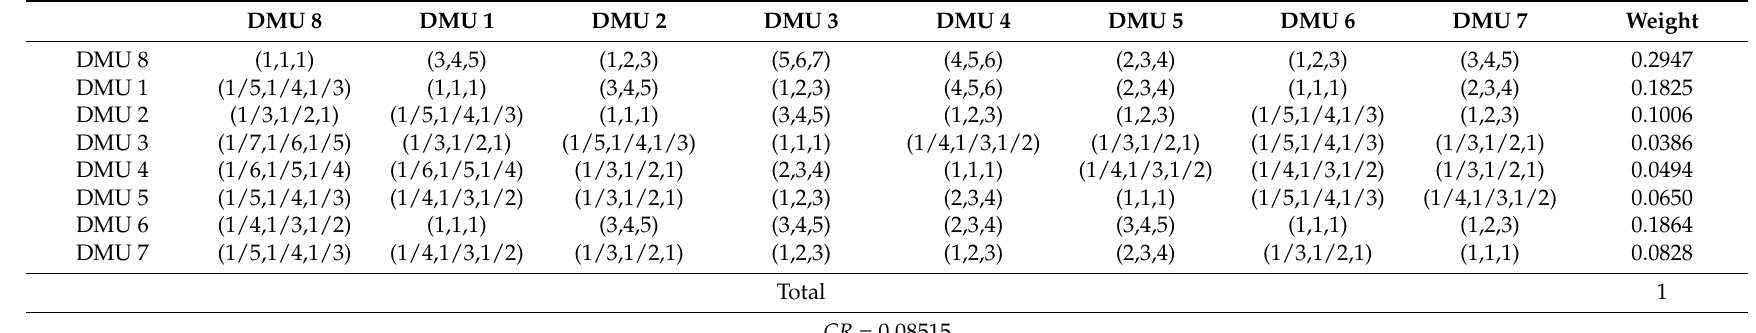
Table A23. Comparison matrix for DCU based on